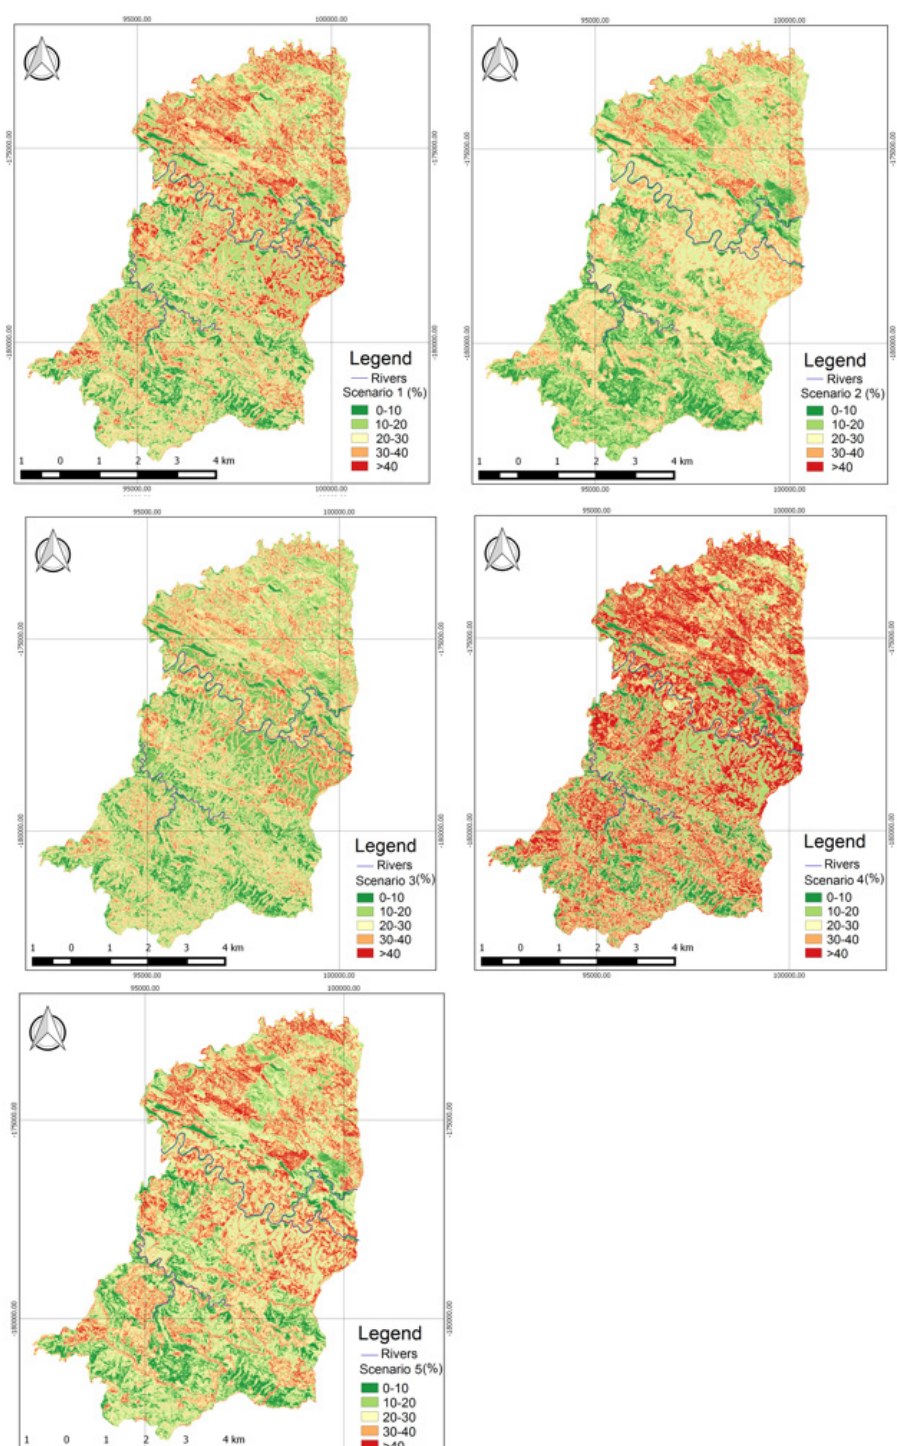
Figure 10. Scenarios tested through the GeoDecision tool.